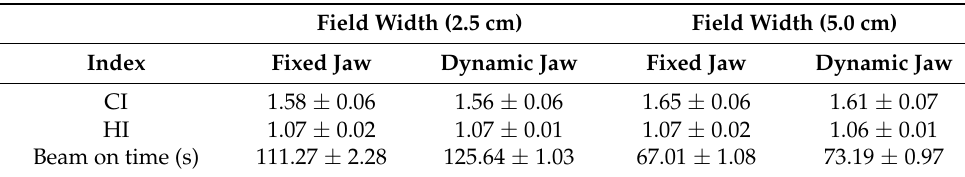
Table 1. CI and HI of treatment target according to jaw mode (fixed and dynamic) and jaw width (2.5 cm and 5.0 cm).